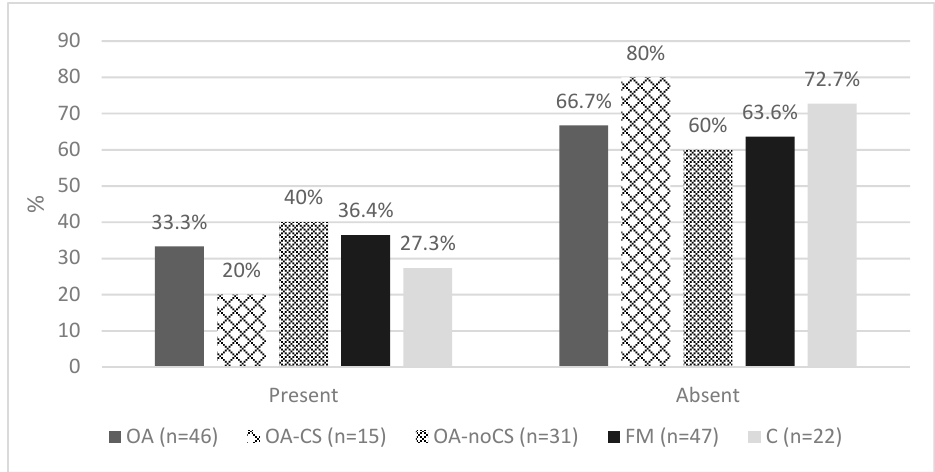
Figure 4. Presence/absence of TCI-R personality disorders by group. Note. TCI-R: Temperament and Character Inventory, OA: osteoarthritis, OA-CS: osteoarthritis with central sensitization, OA-noCS: osteoarthritis without central sensitization, FM: fibromyalgia, C: